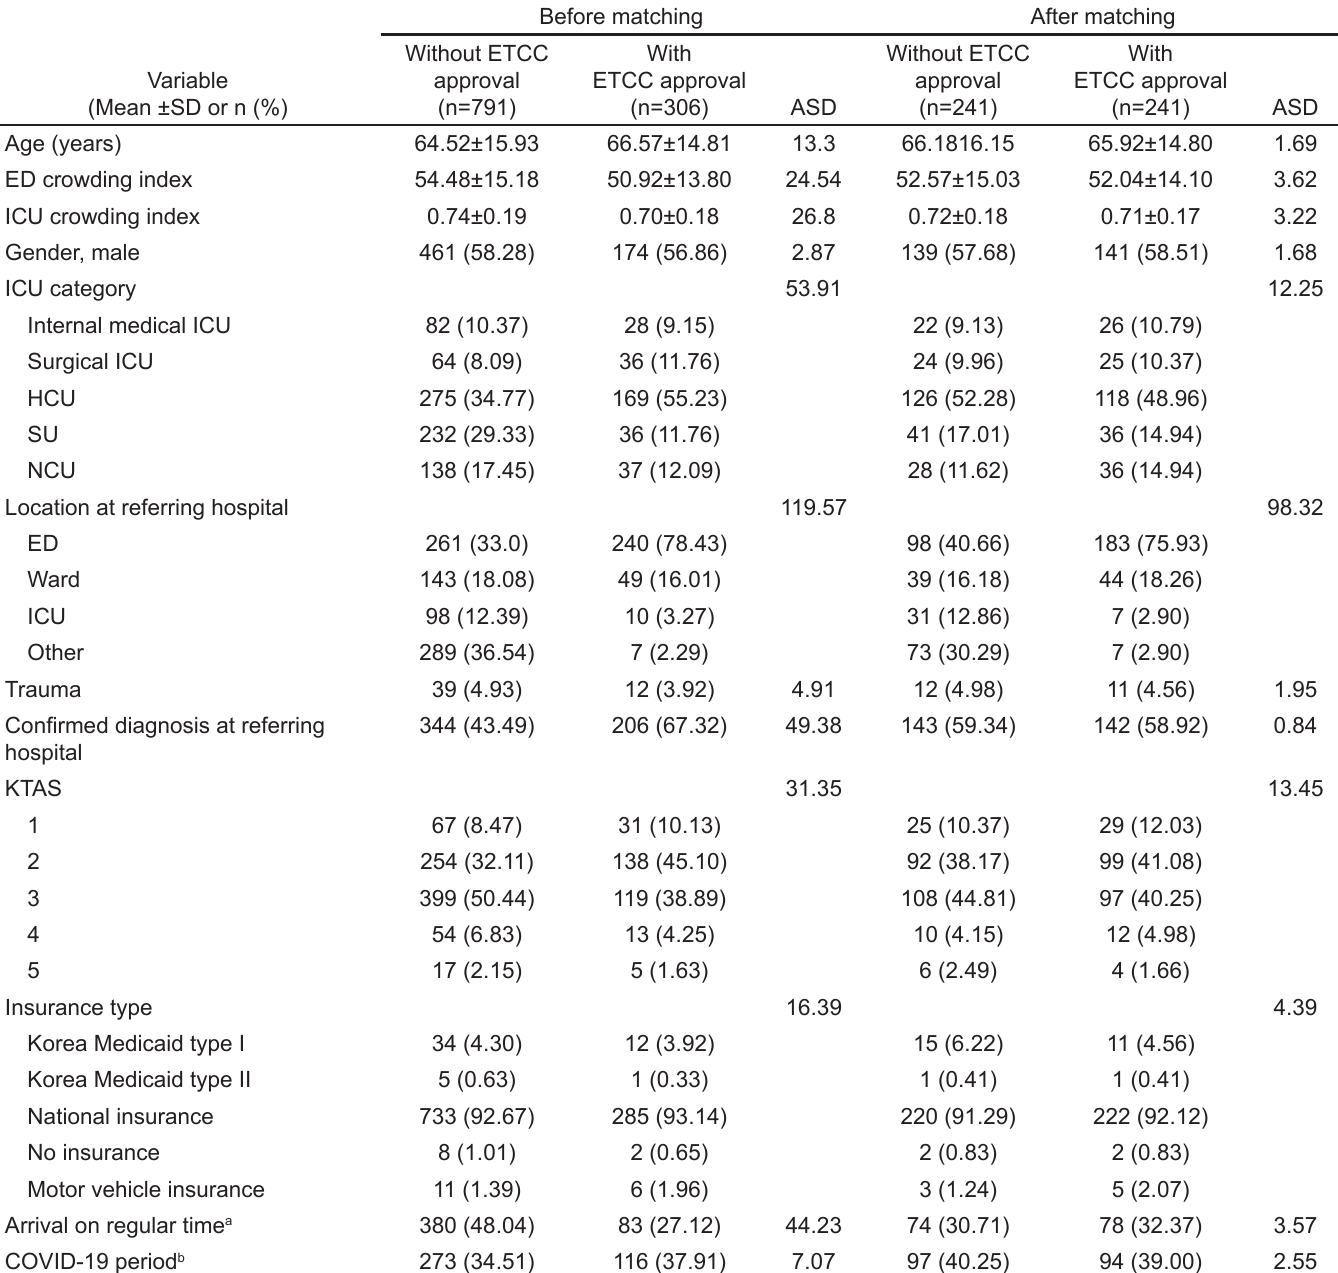
Table 1. Baseline characteristics before and after